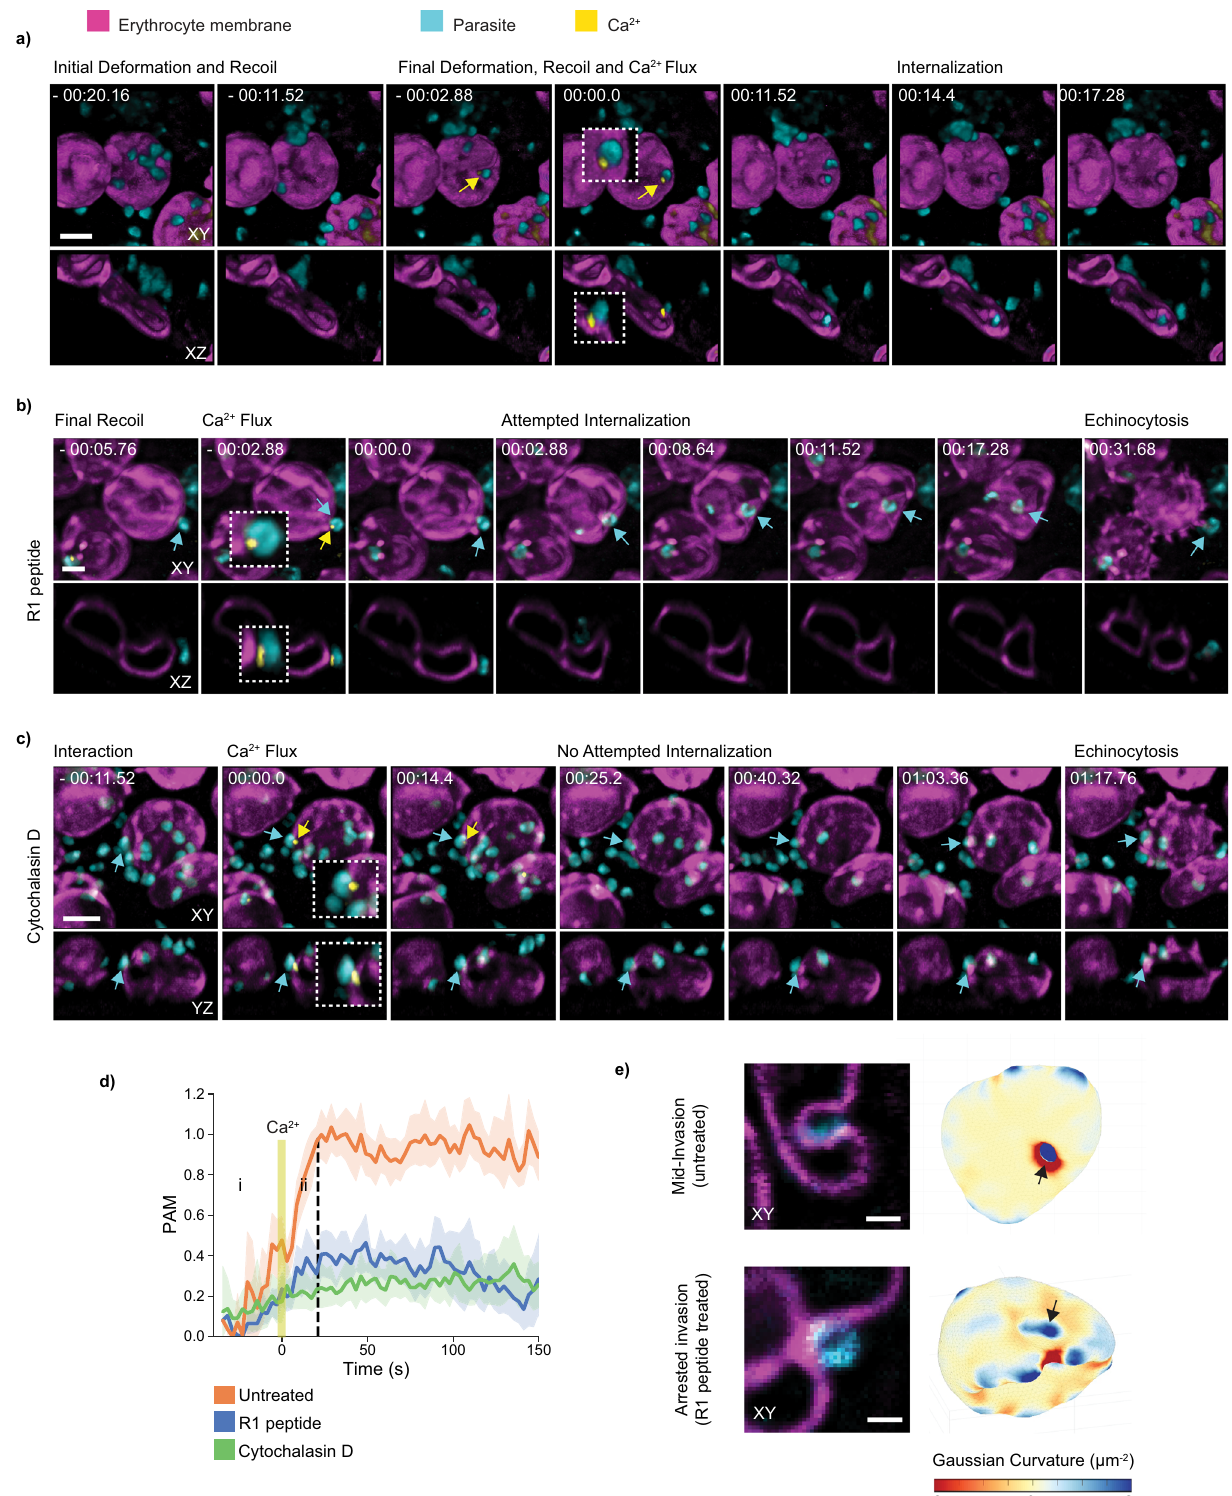
Membrane remodeling has an important role in echinocytosis . A poorly understood stage of the invasion process is that of echinocytosis. Echinocytosis is transient in nature, lasting for a few minutes before the invaded cell returns close to its original morphology 6 . Studies have previously suggested a role for Ca 2 + in the process, but are yet to fi nd a clear link 15 . One possible hypothesis has been that activation of the Gardos channel,